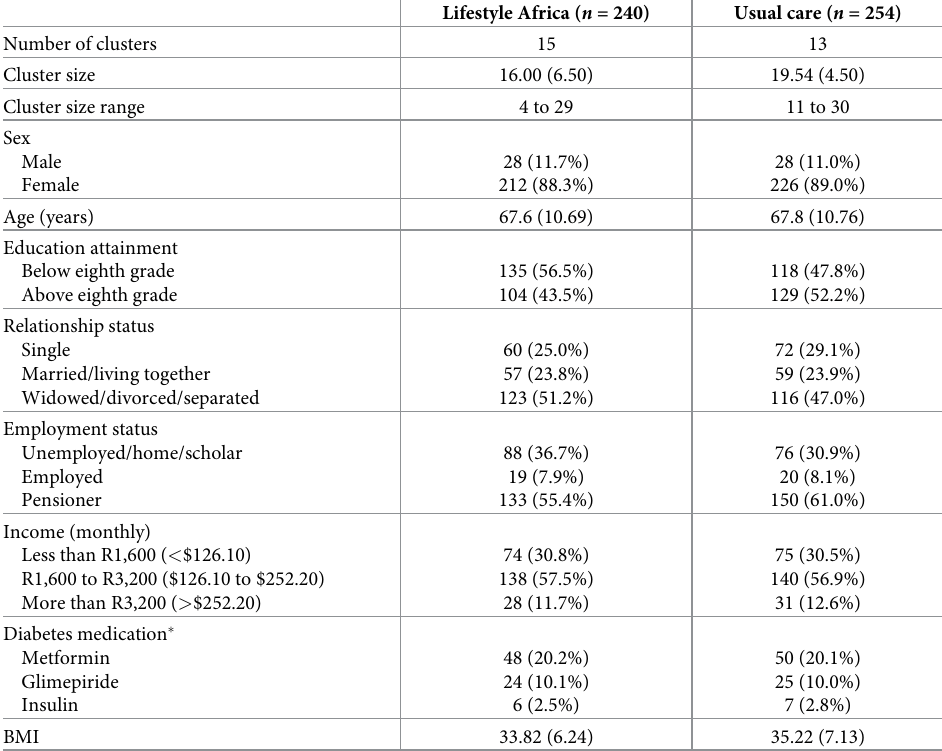
Table 1. Participant baseline